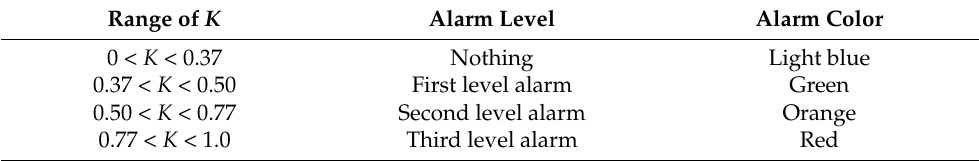
Table 4. Classification of overflow alarm by K